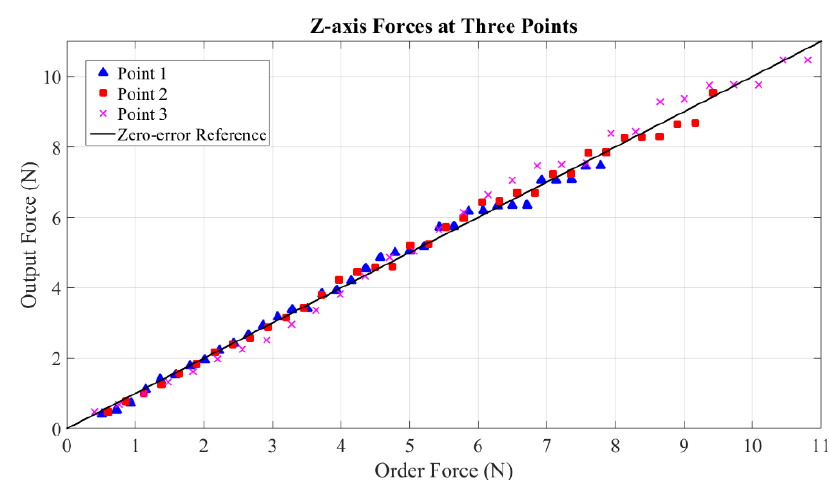
Figure 20. Forces at three points along Z-axis.